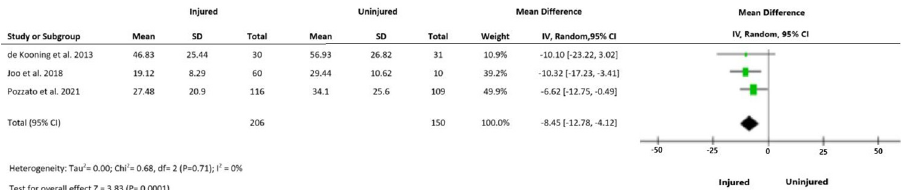
Fig 2. Outcome 1: Difference in RMSSD (ms) between injured and uninjured groups.